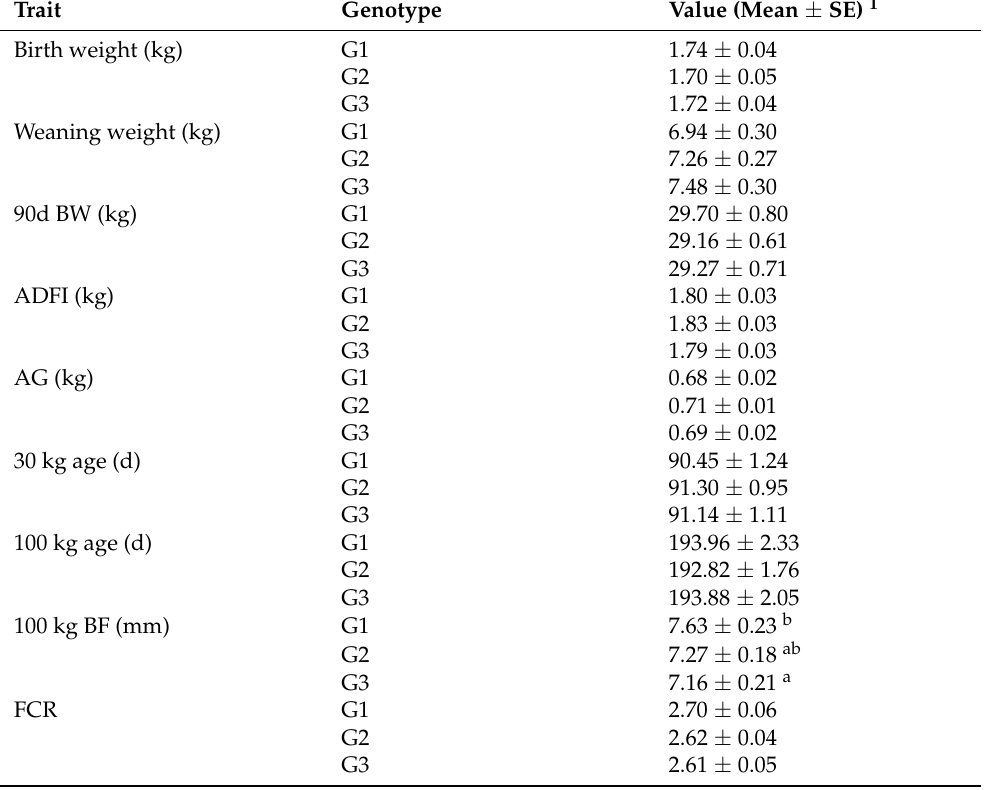
Table 4. Association of each genotype of GPX2 with different feed efficiency traits.